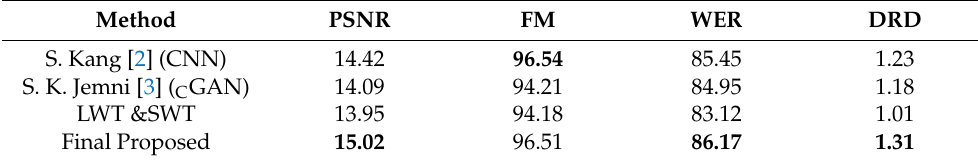
Table 2. Comparative results on Noisy Office [30] dataset.